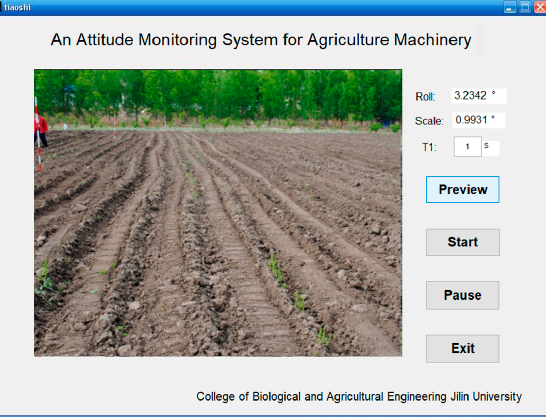
Figure 12. Program operation interface.